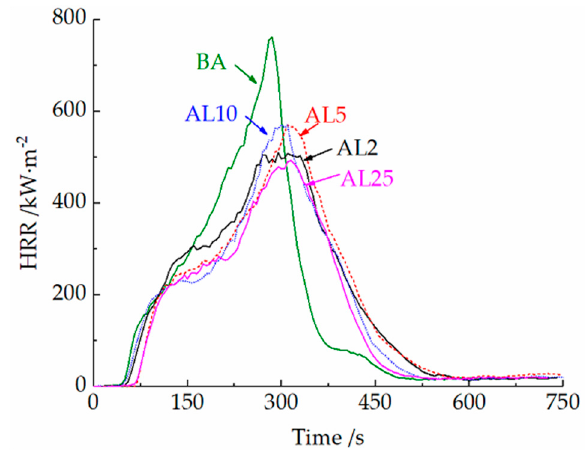
Figure 6. Heat release rate of asphalt binders.